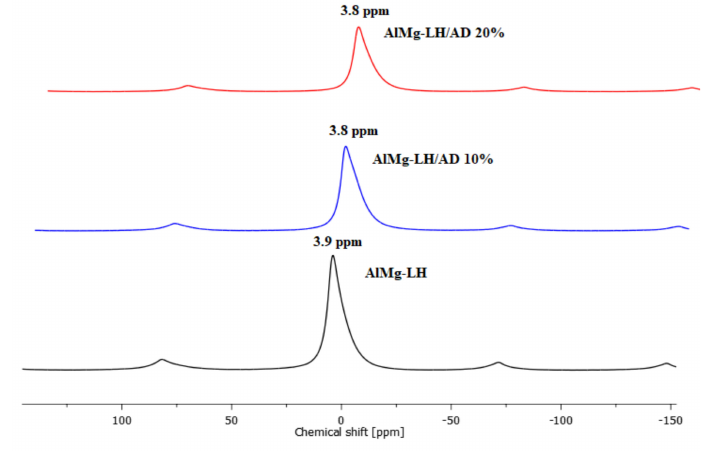
Figure 3. Solid state nuclear magnetic resonance 27 Al MAS NMR spectra for AlMg − LH, AlMg − LH/AD 10%, and AlMg − LH/AD